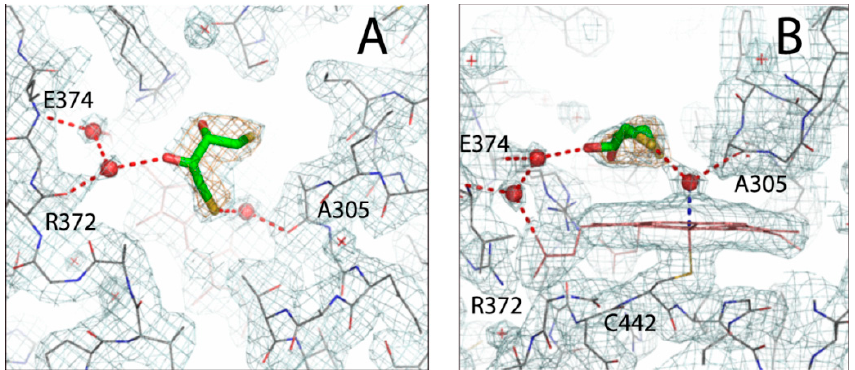
Figure 3. ( A ) Packing of CYP3A7 in the crystal lattice. Intermolecular contacts are mediated by the D-helices (in blue and black) and G ′ -helices (in yellow and teal). Sulfate ions bridging the D-helices are shown in cpk representation. ( B , C ) Magnified views at the polar and hydrophobic interface formed by the antiparallel D- and G ′ -helices, respectively. The interacting residues are displayed and labeled. Red dotted lines are H-bonds; red spheres are water molecules.